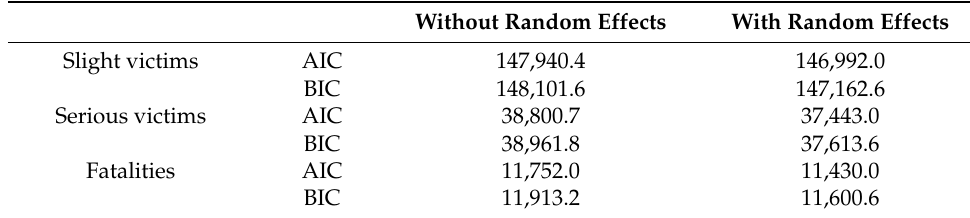
Table 3. Comparison of binomial regressions without and with random effects. Without Random Effects